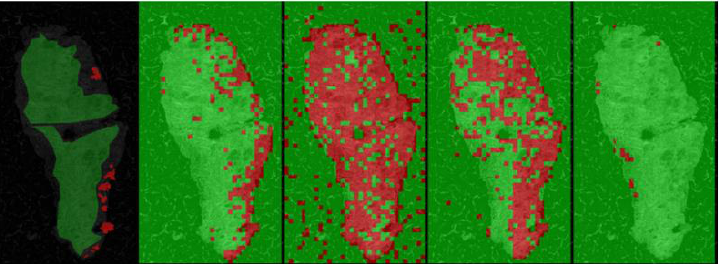
Figure 17. Ground truth labeling (left — black background) and network predictions comparison (from left to right): proposed method, InceptionV3 pre-trained, VGG16 pre-trained, VGG16 fine- tuned (green: normal, red: BCC). Reprinted with permission from [207]. Copyright 2018 IEEE: IEEE Proceedings.